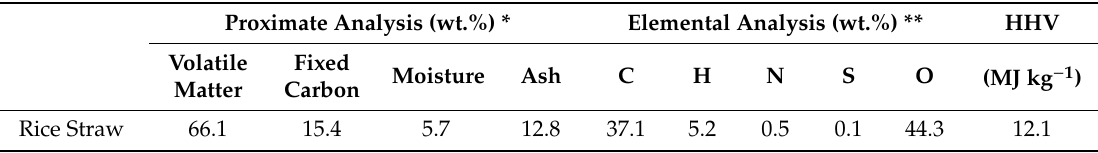
Table 1. Characterization of rice